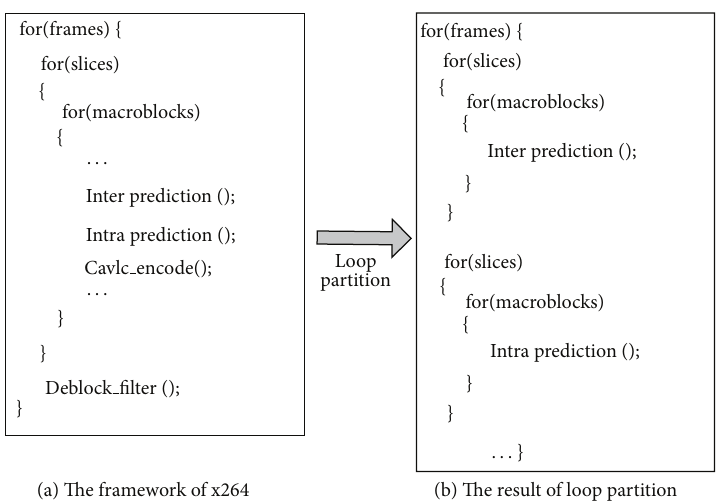
Figure 2: The loop partition of x264.